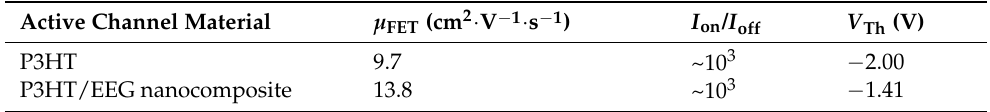
Table 1. Average field-effect mobilities, on–off current ratios, and threshold voltages for textile-OFETs based on P3HT and P3HT/EEG nanocomposite as active channel materials. Active Channel Material µ FET (cm 2 · V − 1 · s − 1 ) I on / I off V Th (V) P3HT 9.7 ~10 3 −